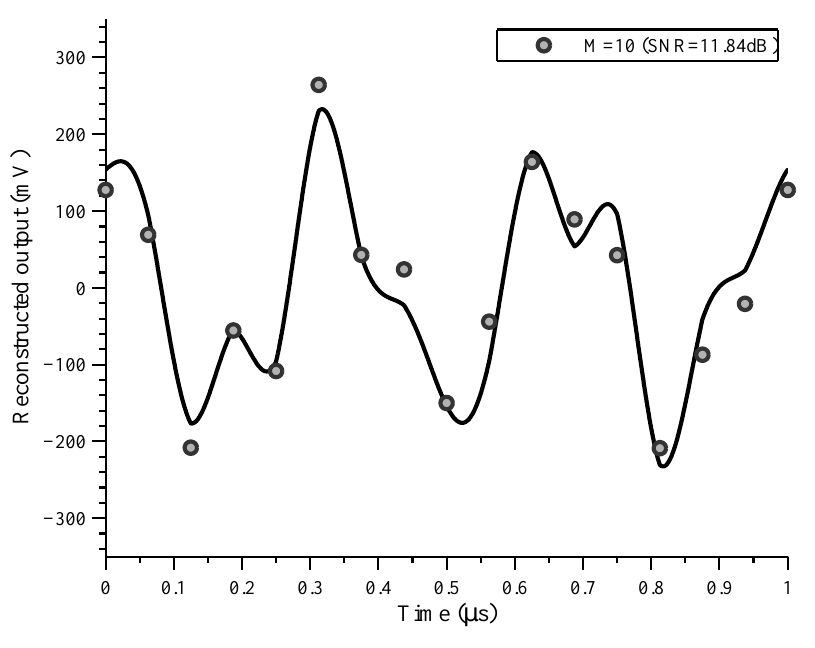
Figure 14. Compressive reconstruction of input signal composed of two randomly chosen basis elements with random amplitudes.